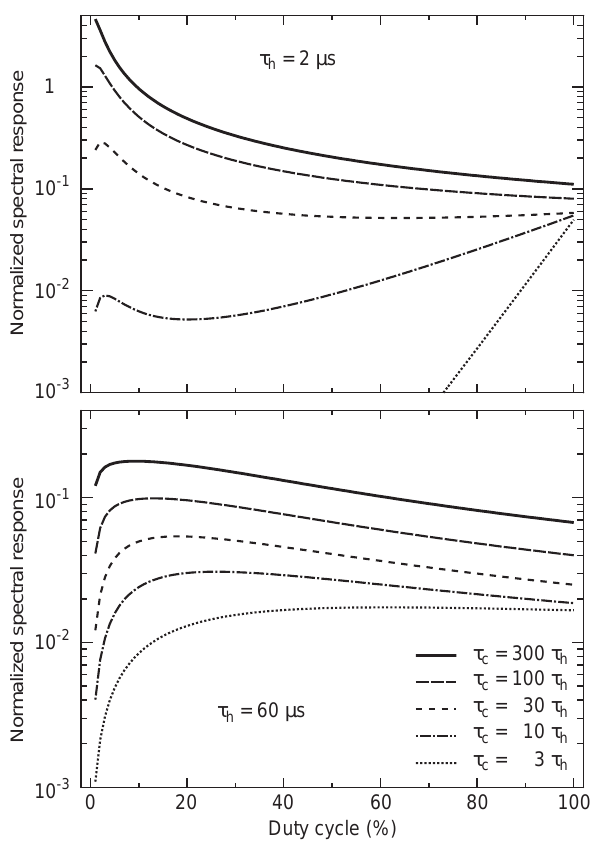
Fig. 11. Theoretical estimate of the normalised spectral response at 1010 Hz, the first even harmonic of 505 Hz, produced by modulated ionospheric currents, plotted for a range of five cooling time constants. The curves have been displaced vertically to assist comparison. Upper panel data computed for a heating time constant of 2 l s. Lower panel data computed for a heating time constant of 60 l s